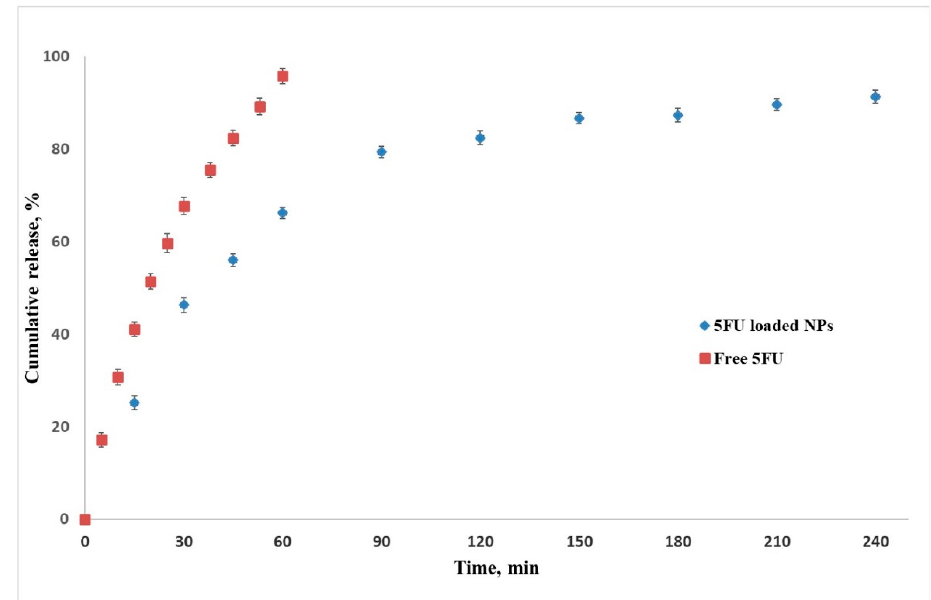
Figure 3. 5-fluorouracil release profile from SF/PEG NPs. Data shown as the mean ± SD (n = 3).